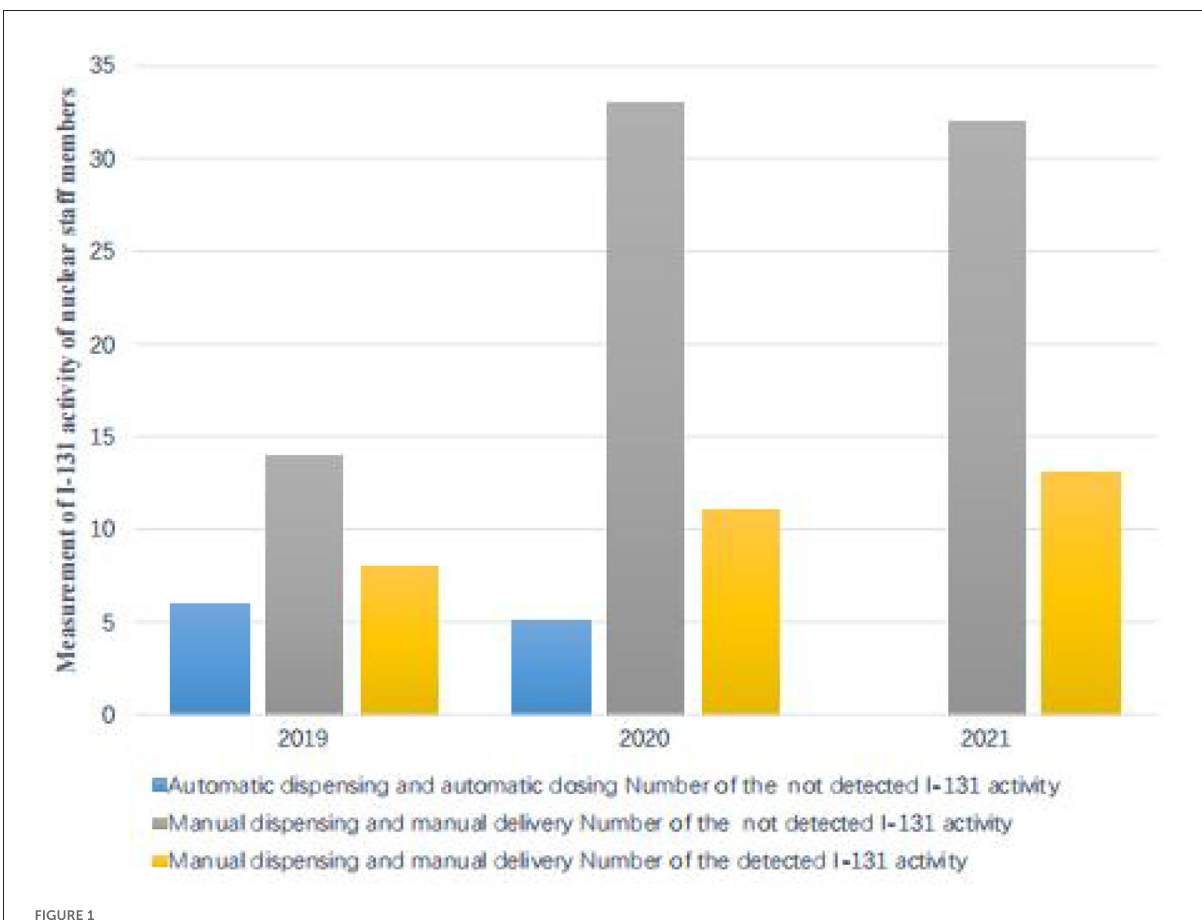
FIGURE1 Measurement of 131 I activity in the thyroid of nuclear medical staff members under